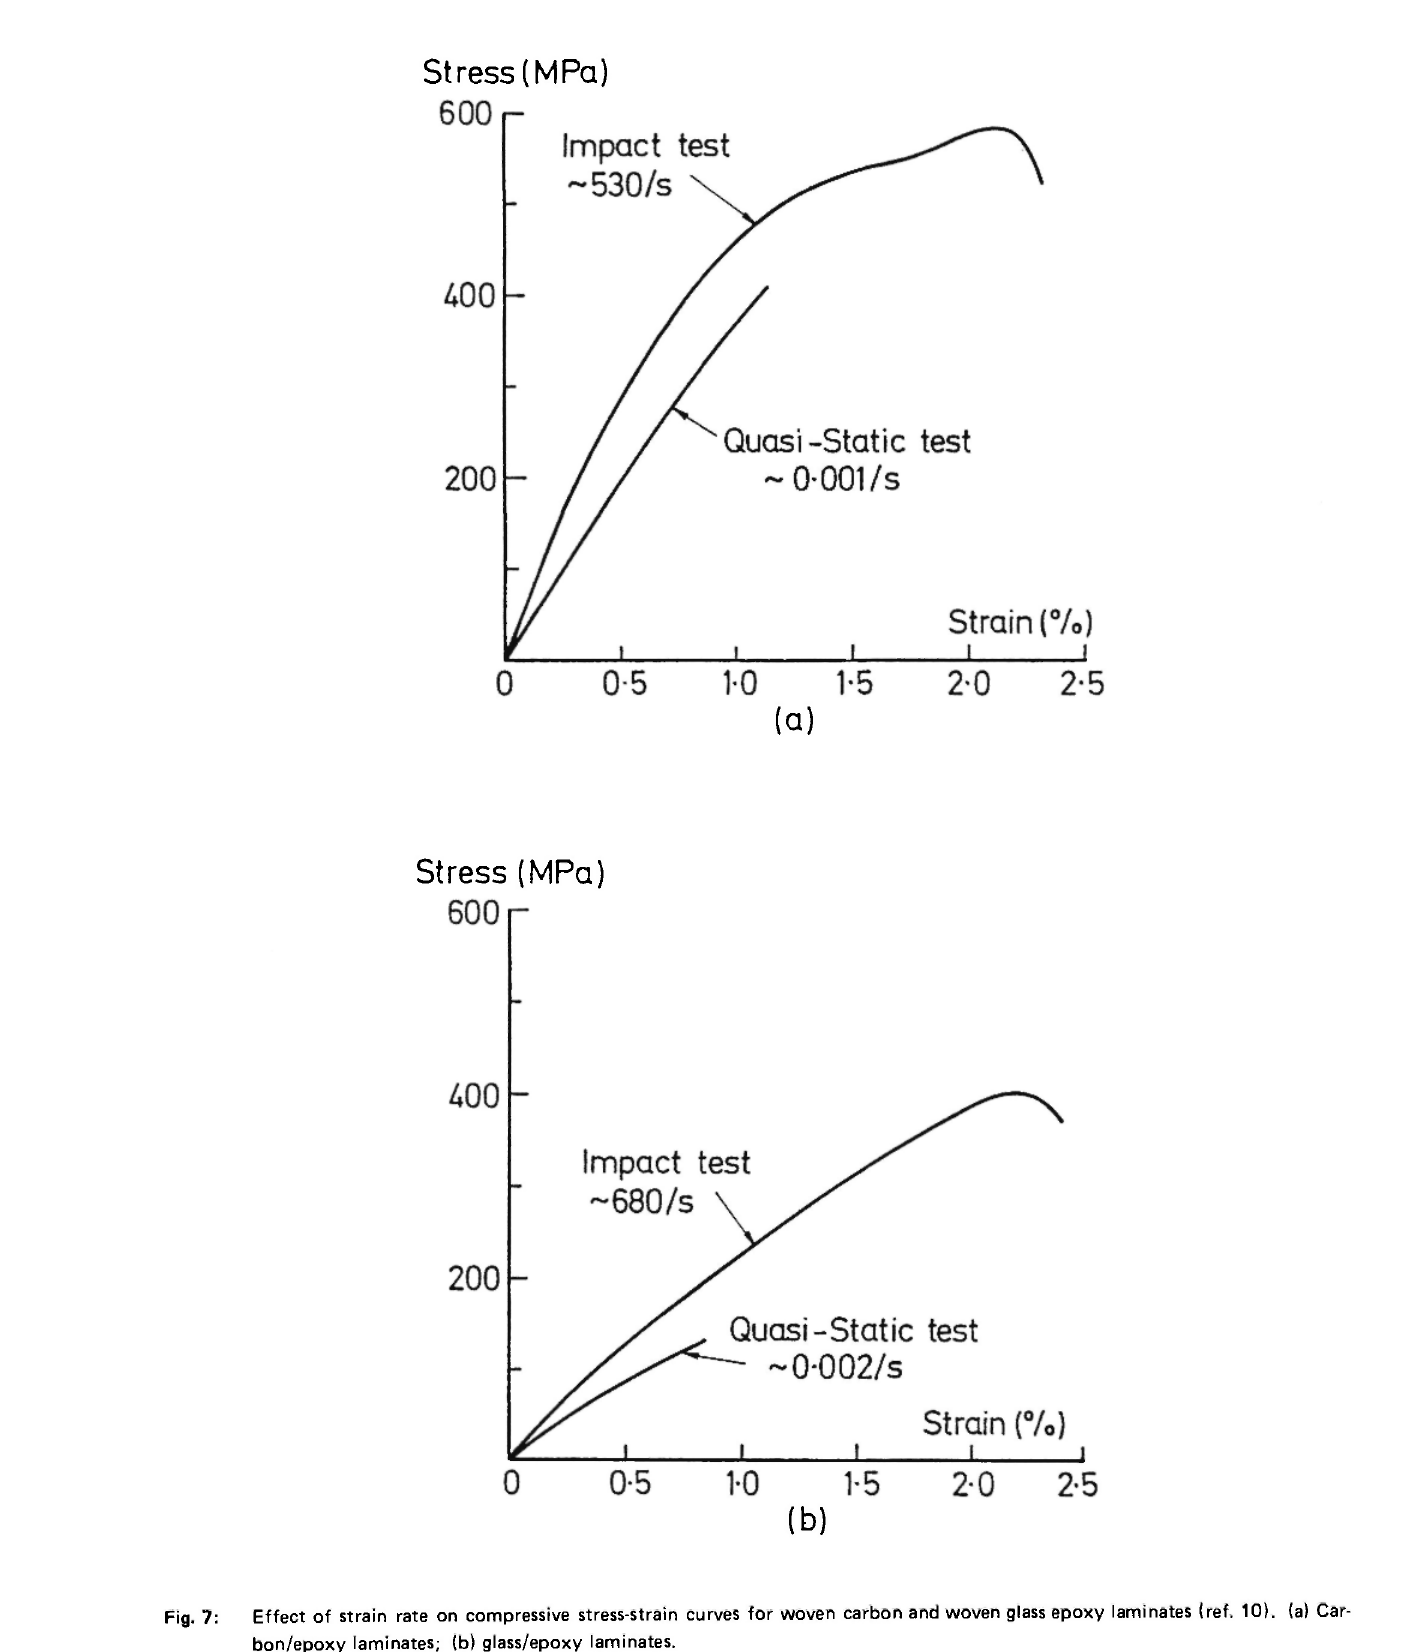
Fig. 7: Effect of strain rate on compressive stress-strain curves for woven carbon and woven glass epoxy laminates (ref. 10). (a) Car- bon/epoxy laminates; (b) glass/epoxy